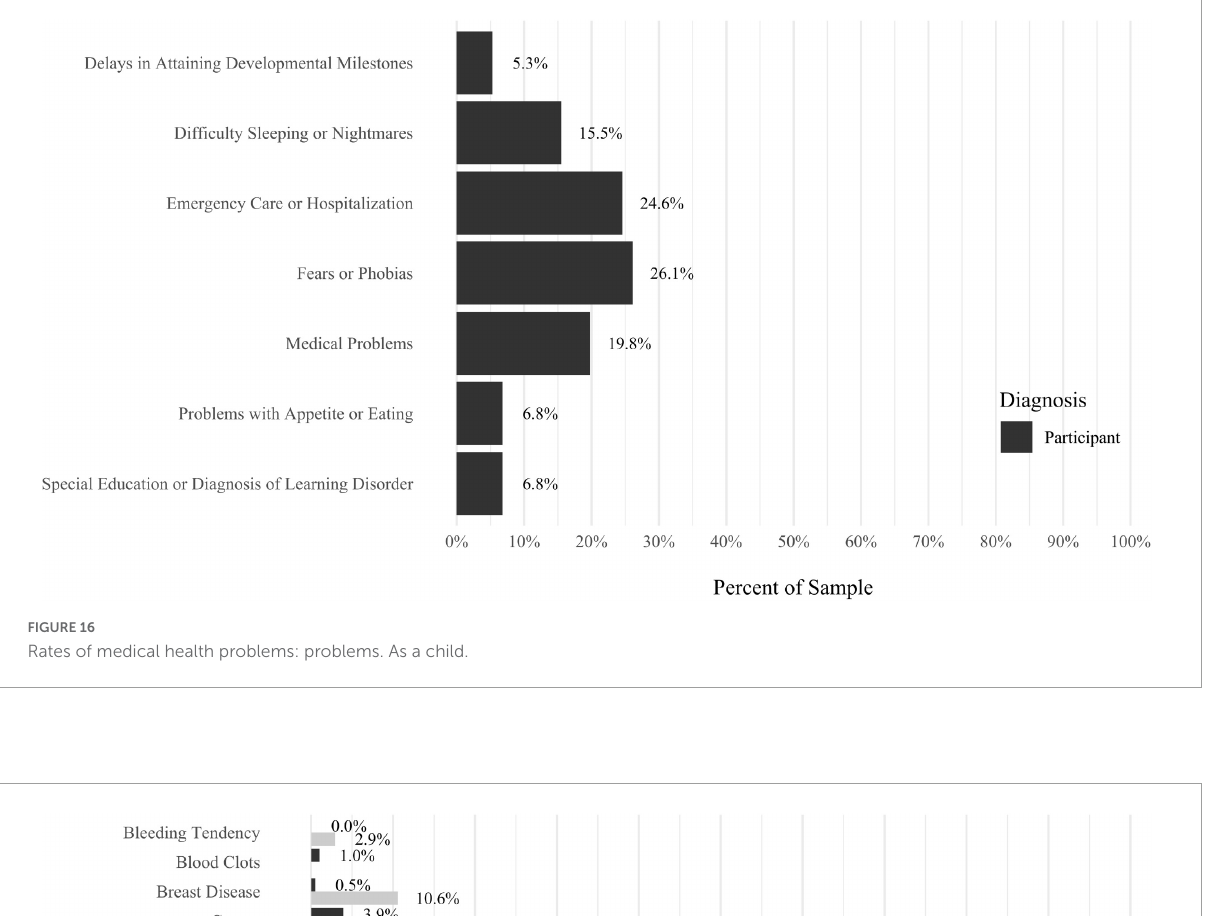
FIGURE16 Rates of medical health problems: problems. As a child.